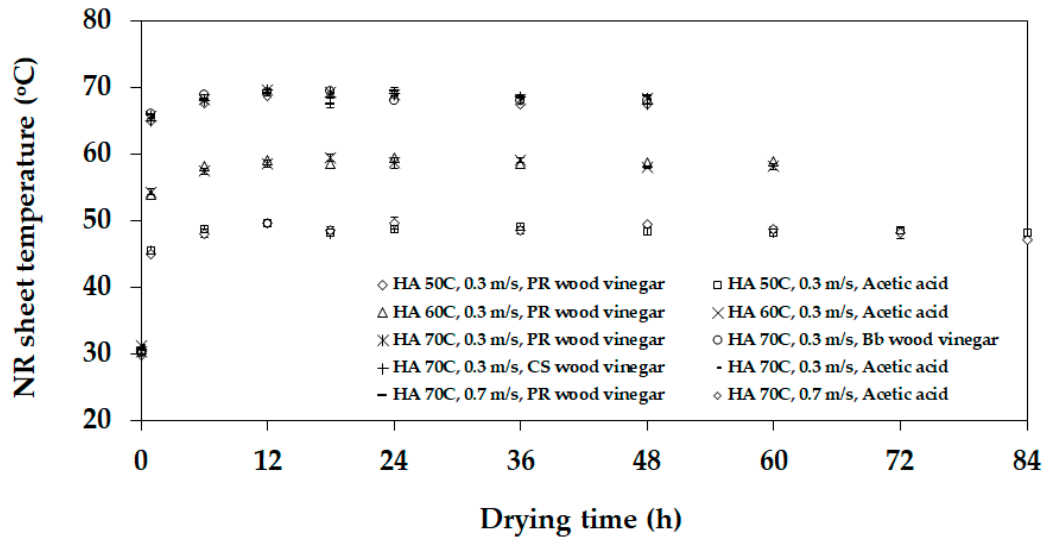
Figure 5. The NR sheet temperature change during the drying process (HA = hot air, PR = para rubber, Bb = bamboo, and CS = coconut shell).